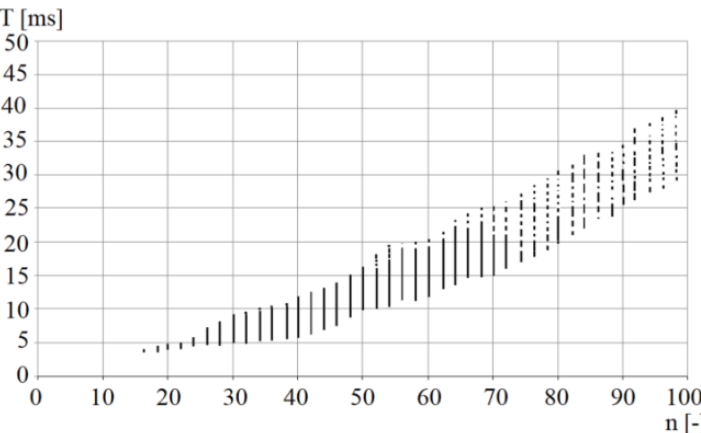
Figure 15. Dependence of the time T on the number of blades n.